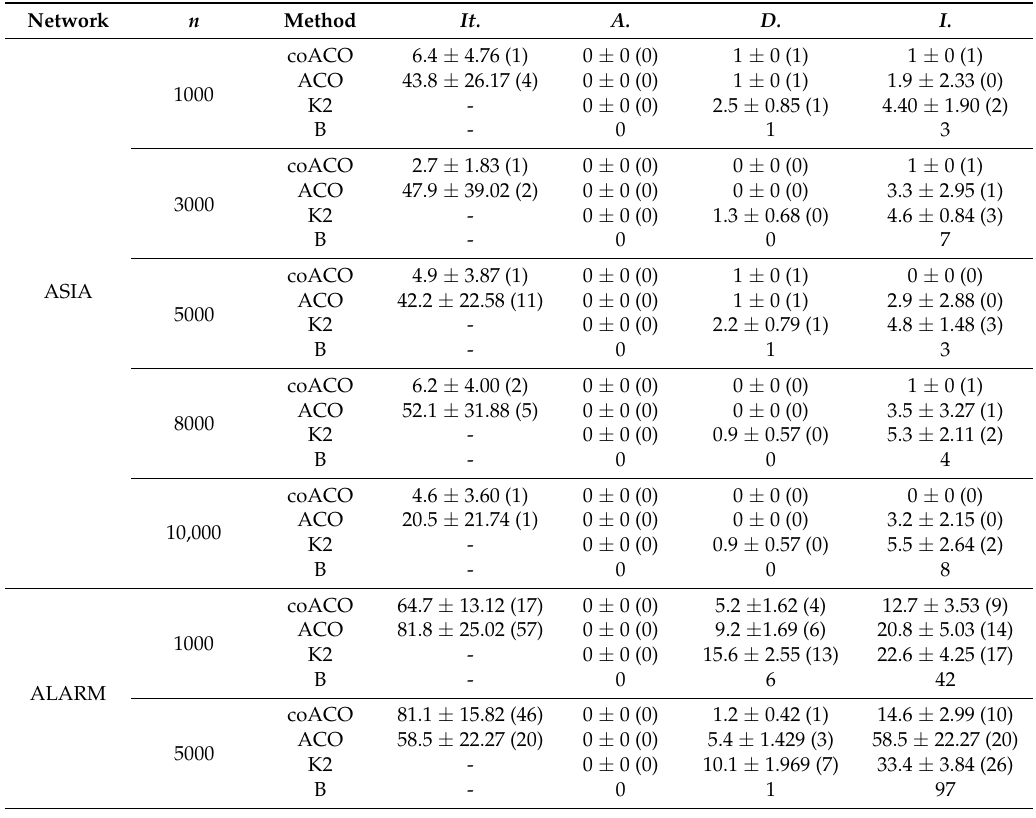
Table 3. Statistical results for various methods ( µ ± σ